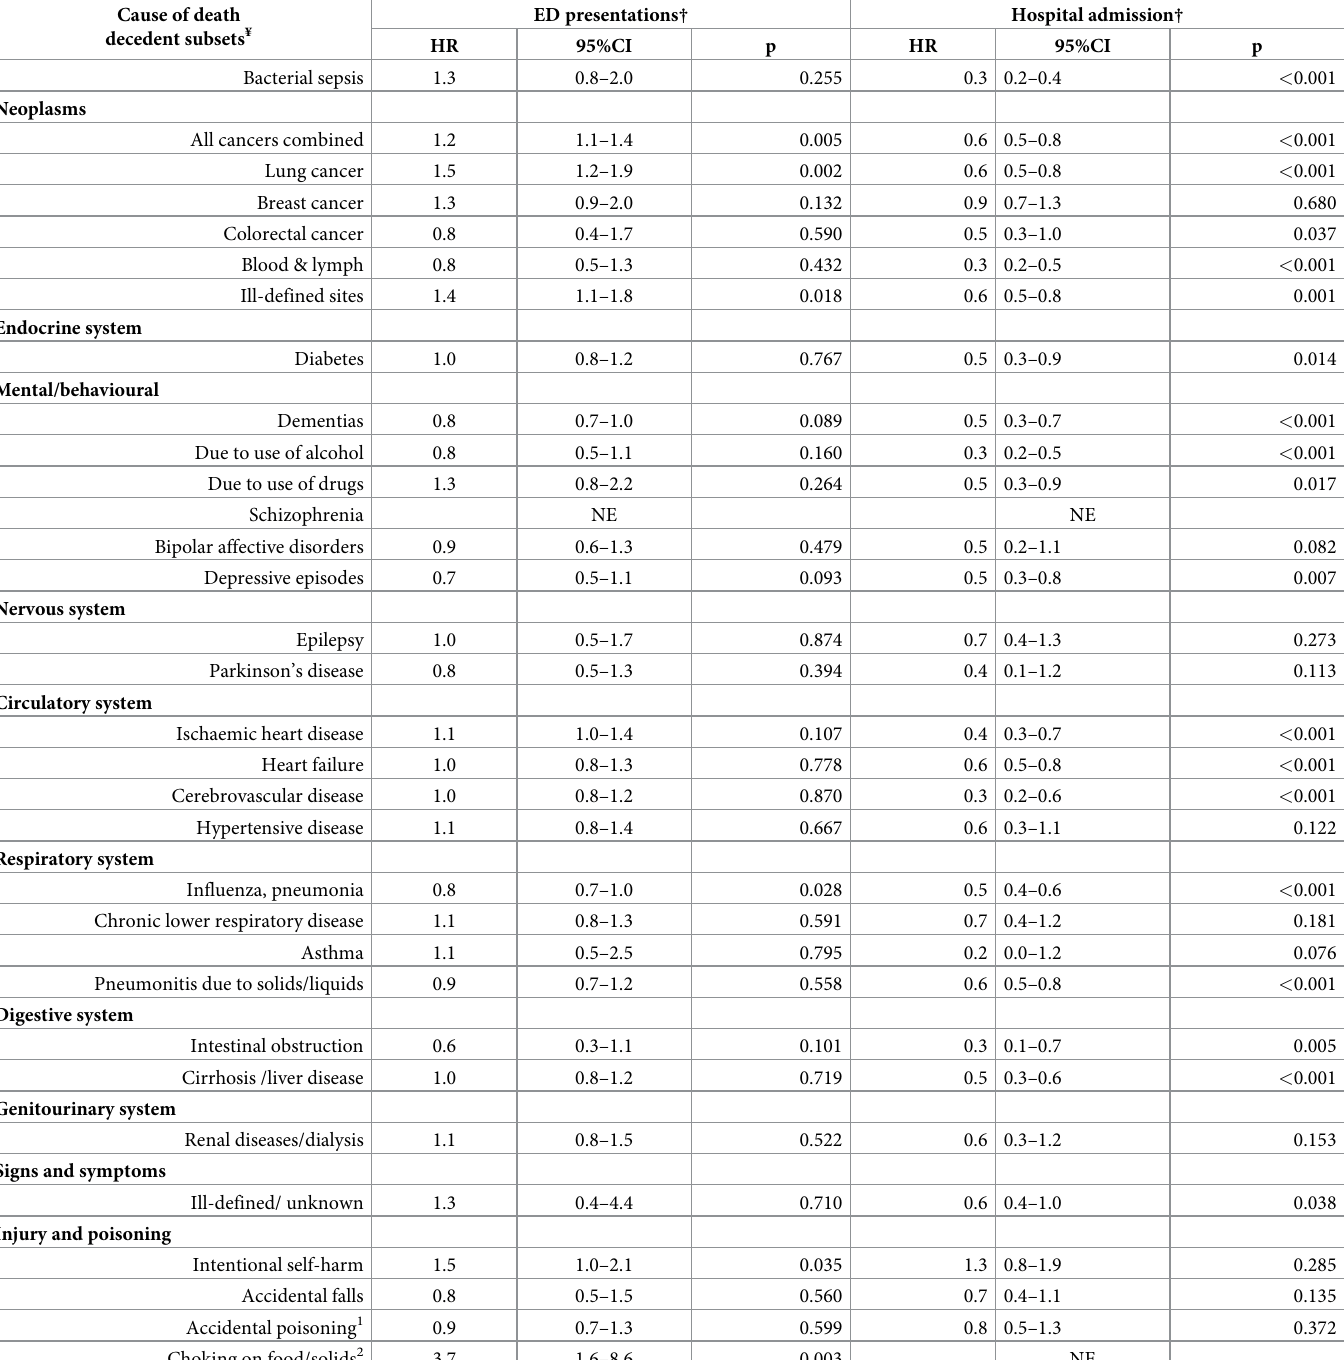
Table 5. Adjusted relative rates of ED presentations and hospital admission by decedents in the schizophrenia cohort compared to decedents in the matched cohort from multiple regression models for each cause of death listed anywhere on the death certificate. Cause of death decedent subsets